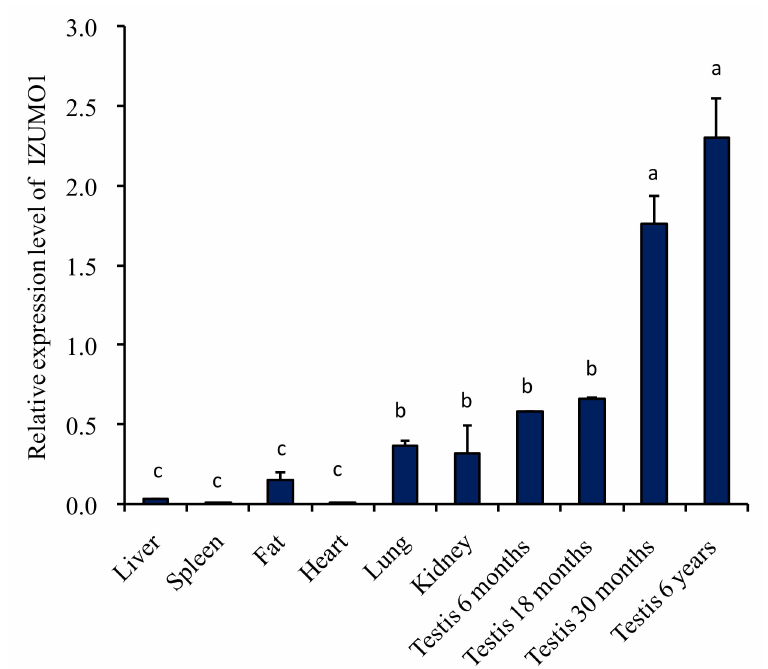
Figure 2. Expression of IZUMO1 mRNA in various organs of Datong yak by quantitative real time PCR. Data are presented as means ± standard deviation ( n = 4). The error bar indicates the standard deviation (SD). Di ff erent letters indicate significant di ff erence ( p <